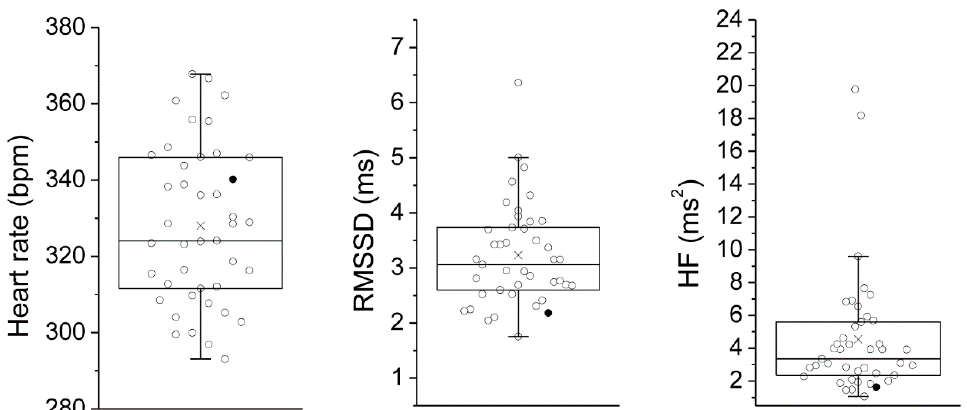
Figure 2. Box and whisker plots of the distribution of 24-h values of heart rate, RMSSD and HF in 42 wild-type Groningen rats. The empty circles indicate individual animals and the black circles indicate the rat that developed lethal ventricular tachycardia after isoproterenol administration. Circles beyond the whiskers represent outliers, according to the “1.5 × Inter-Quartile range rule”. RMSSD = root mean square of successive beat-to-beat interval differences; HF = high frequency.